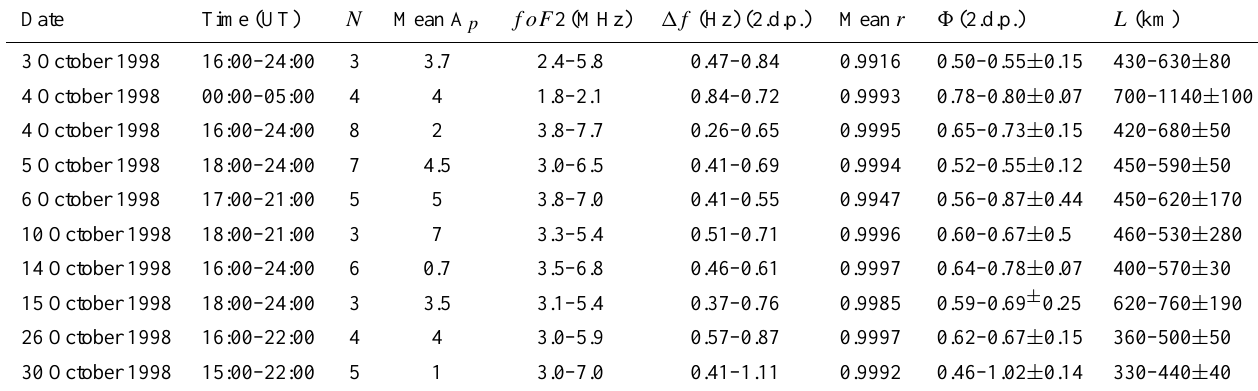
Table 1. Summary of the IAR resonance feature analysis for October 1998. The 2nd column shows the approximate times between which IAR spectral resonance features were observed in the pulsation magnetometer data from Sodankyl¨a, Finland. The 3rd column gives the number of harmonics that were clearly visible in the dynamic colour spectra. Column 4 shows the average A p index during the resonance feature observation. The 5th and 6th columns indicate how the f 0 F 2 critical frequency measured by the ionosonde at Sodankyl¨a and the resonance feature spacing varied from the start to finish of the resonance features. Column 7 gives the average product moment correlation coefficient over the resonance feature observations. This is the mean of the hourly correlations between resonance peak frequency and harmonic number. The 8th and 9th columns indicate the range of values of 8 and L calculated for each time interval, and their associated